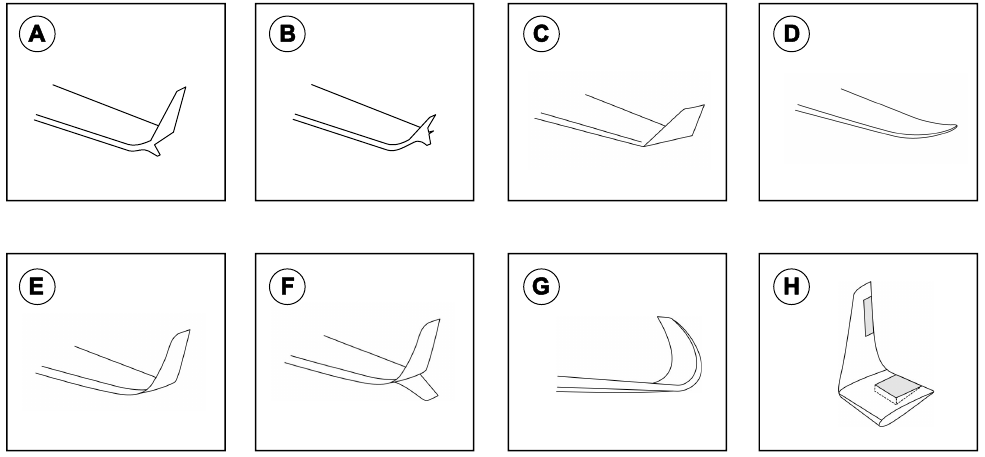
Figure 2. Different types of winglets and wingtip devices commonly used. ( A ) Whitcomb winglet; ( B ) Tip fence; ( C ) Canted winglet; ( D ) Raked wingtip; ( E ) Blended winglet; ( F ) Blended split winglet; ( G ) Sharklet; ( H ) Active